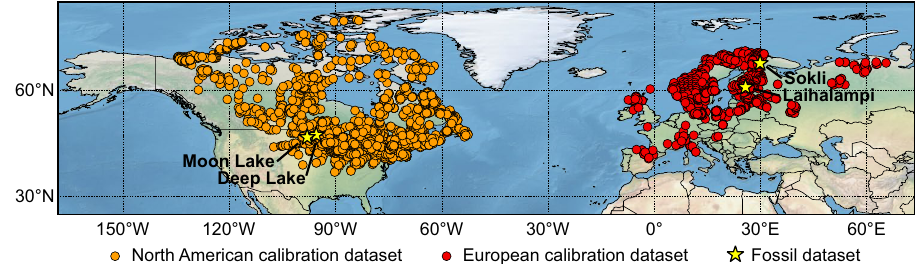
Figure 1. Modern and fossil pollen datasets in North America and